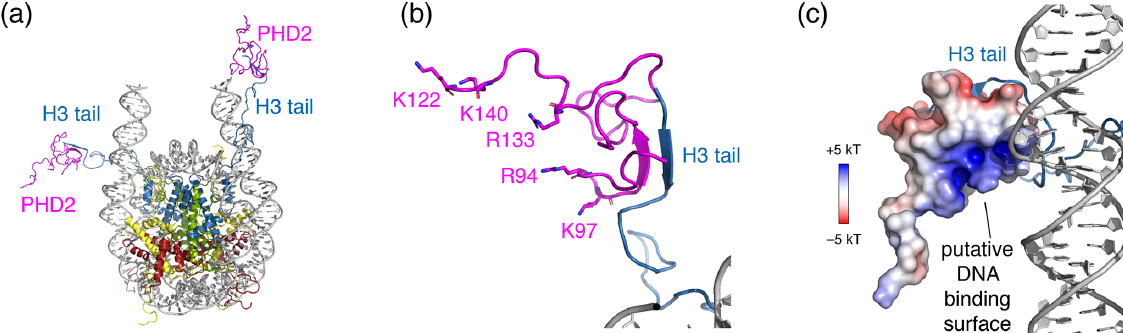
Figure 6. Structural model of the PHD2–nucleosome complex derived using HADDOCK. (a) Model of the complex based on the H3 tail conformation as seen in the crystal structure (PDB entry 1KX5). The H3 tail residues 1–6 form a beta sheet with PHD2. (b) Zoom on the PHD2–H3 tail interaction. Opposite of the H3 tail-binding site, the PHD2 surface features a ridge of positively charged residues, shown as sticks and labeled. (c) Model of the complex when enforcing contacts between the positively charge ridge in PHD2 and the DNA, showing contacts between K97 and the nucleosomal DNA. The PHD2 surface is colored by the electrostatic potential calculated by APBS (Jurrus et al., 2018). Note that since the H3 tail is flexible, PHD2 could further reorient, while bound to the H3 tail, to allow more substantial PHD2–DNA contacts. Color coding indicated in the